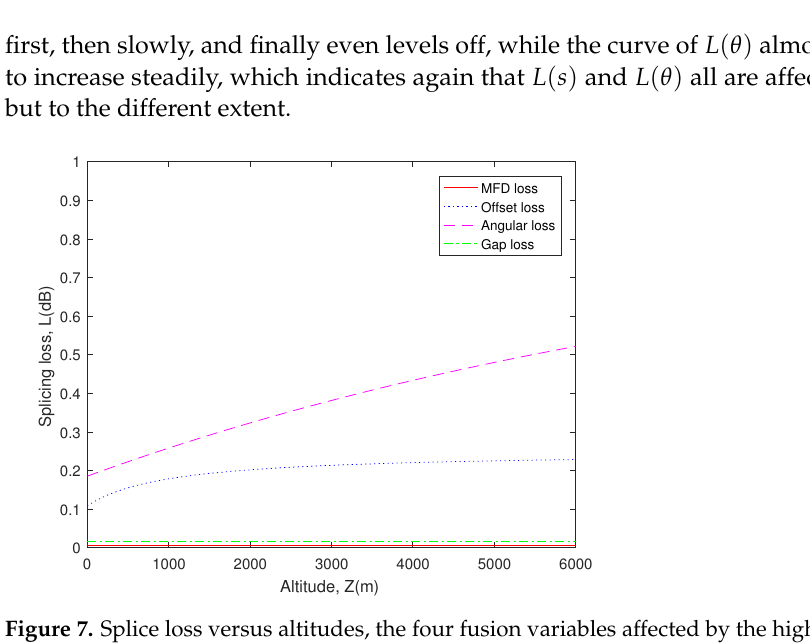
Figure 7. Splice loss versus altitudes, the four fusion variables affected by the high altitude environ- ment have an impact on the splice loss of ULL